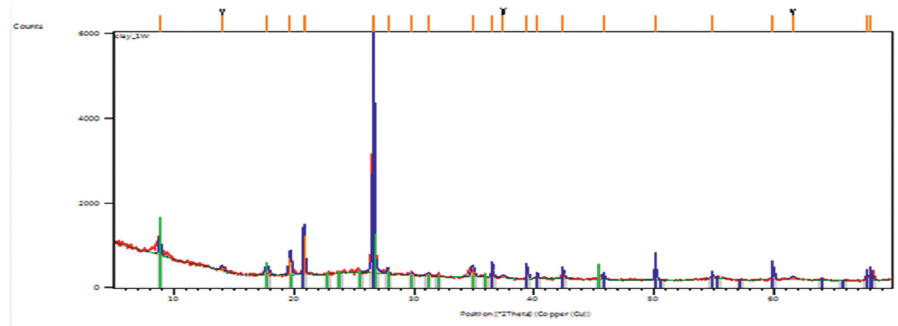
Figure 3: X-ray diffraction spectrum of synthesized ZSM-11.